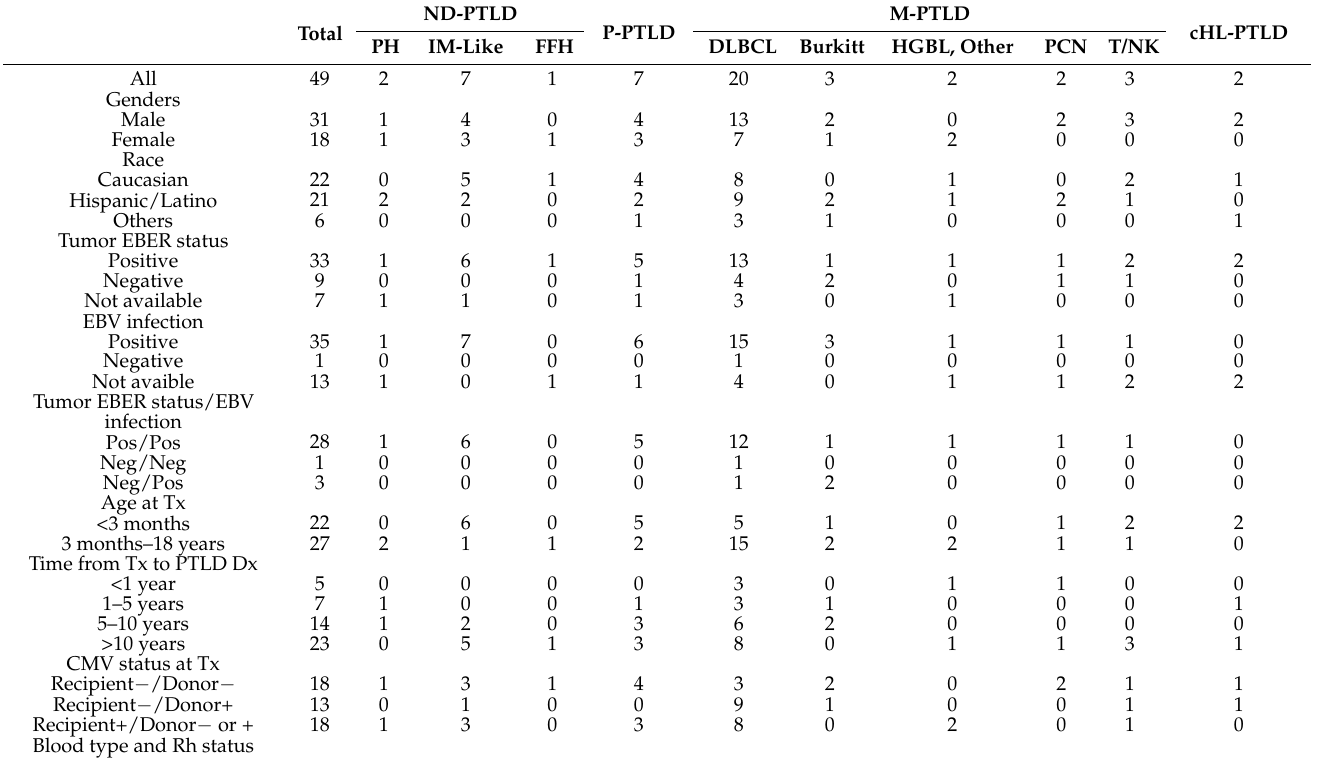
Table 1. Clinical characteristics and subtypes of PTLD.